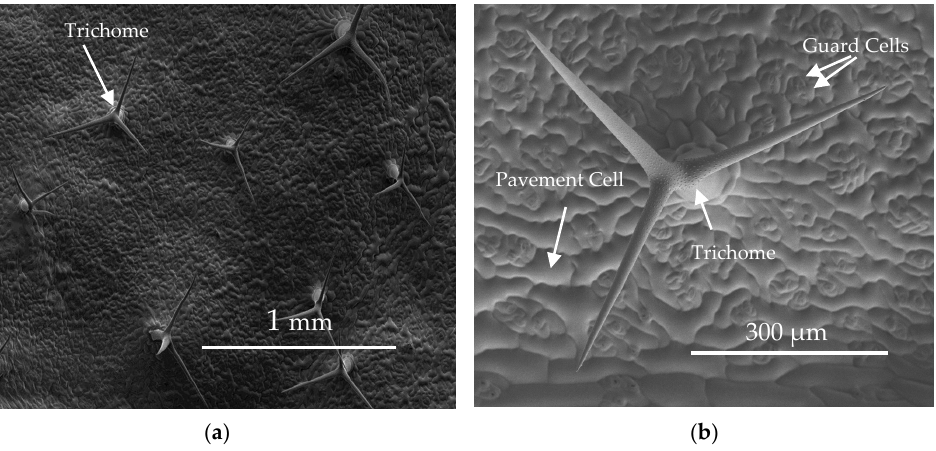
Figure 1. Cryo-SEM images of abaxial Arabidopsis leaf surfaces. ( a ) Comparison of abundance and size of pavement and guard cells covering the leaf surface, relative to the trichome cells protruding out of the surface. ( b ) Detailed view of a single trichome, showing its shape and cell size relative to pavement and guard cells (reprinted from [6,7] with permission). Table 1. Trichome, guard cell, and pavement cell surface areas and cell numbers on adaxial Arabidopsis leaves (adapted from [2]).